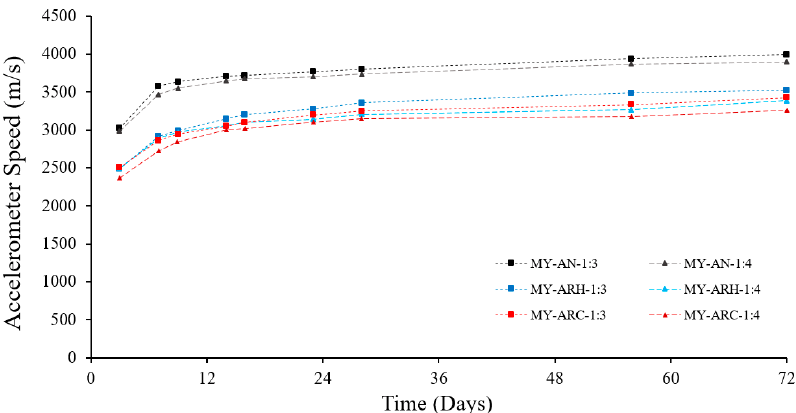
Figure 7. Evolution of the speed calculated through the time measurements collected with the Arduino equipment.